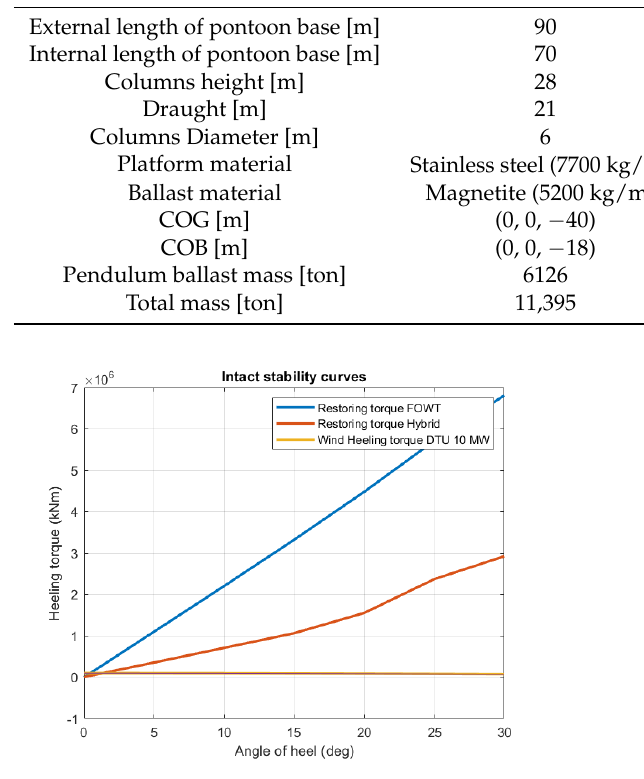
Figure 17. Intact Stability curve for Nautilus hybrid